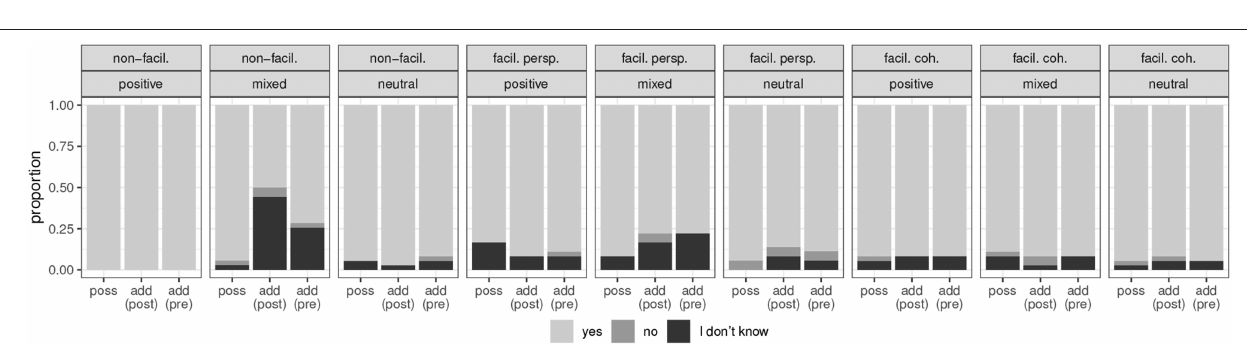
FIGURE 8 | Question proportion results of Experiment 2, split by discourse